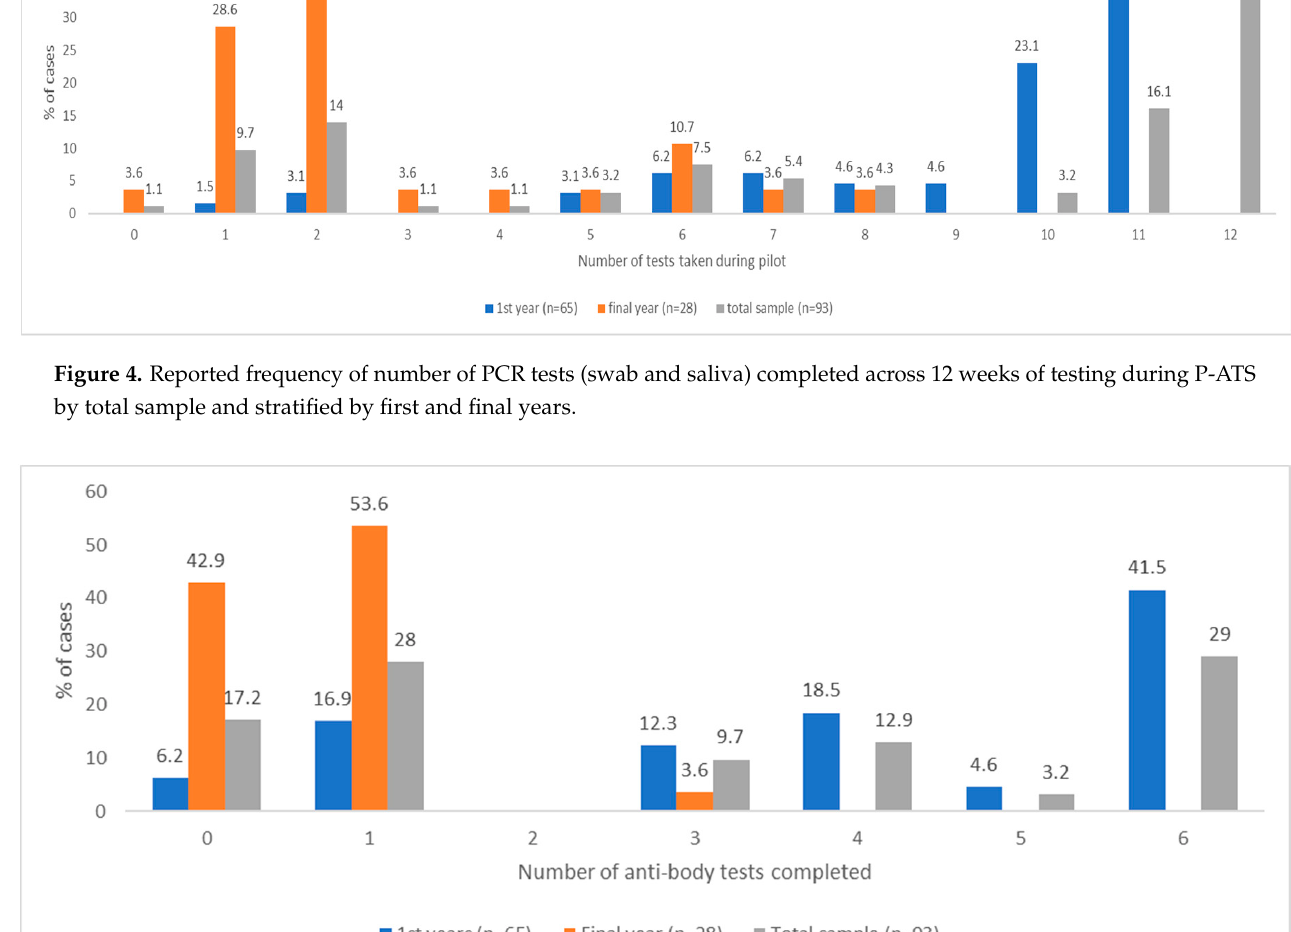
Figure 5. Reported frequency of number of antibody tests completed across 12 weeks of testing during P-ATS by total